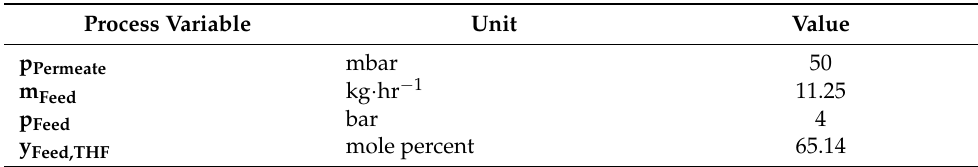
Table 3. Input data vapor permeation